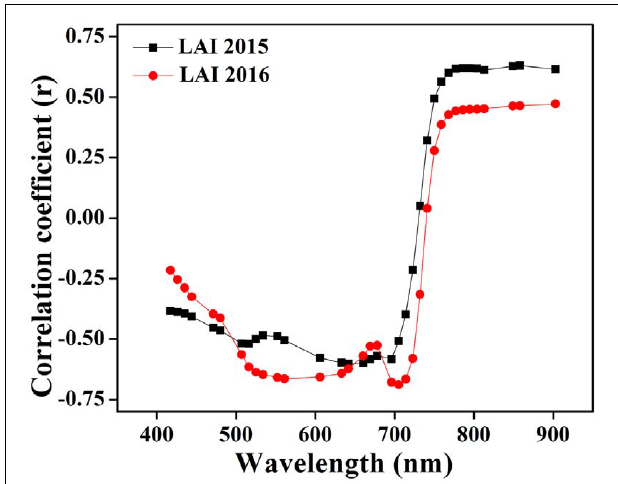
FIGURE 2 | Correlation among LAI and the canopy reflectance at wavelength from 440 to 900 nm using data collected in 2015 and